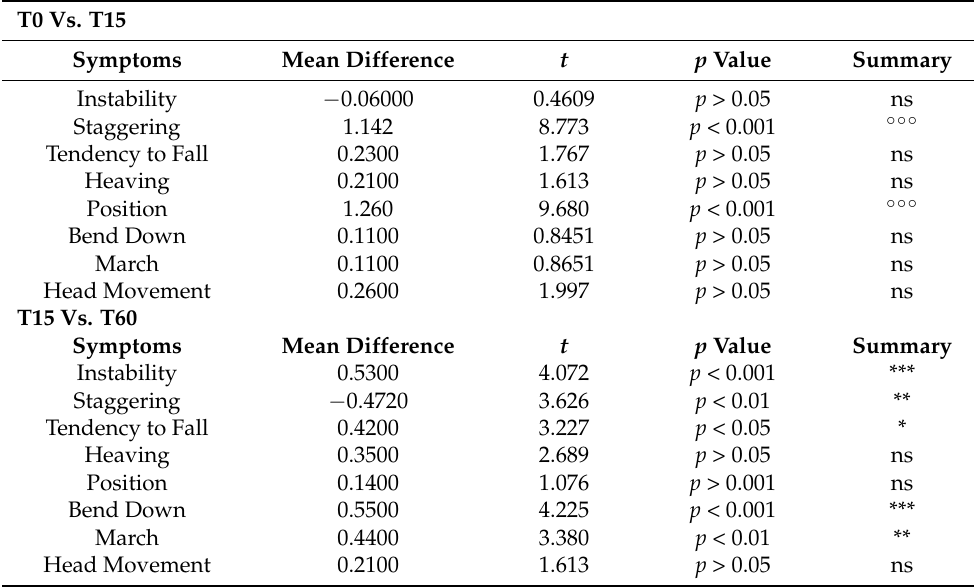
Table 3. Statistical analysis obtained using a Bonferroni post-hoc test on the factors triggering the onset of vertigo.